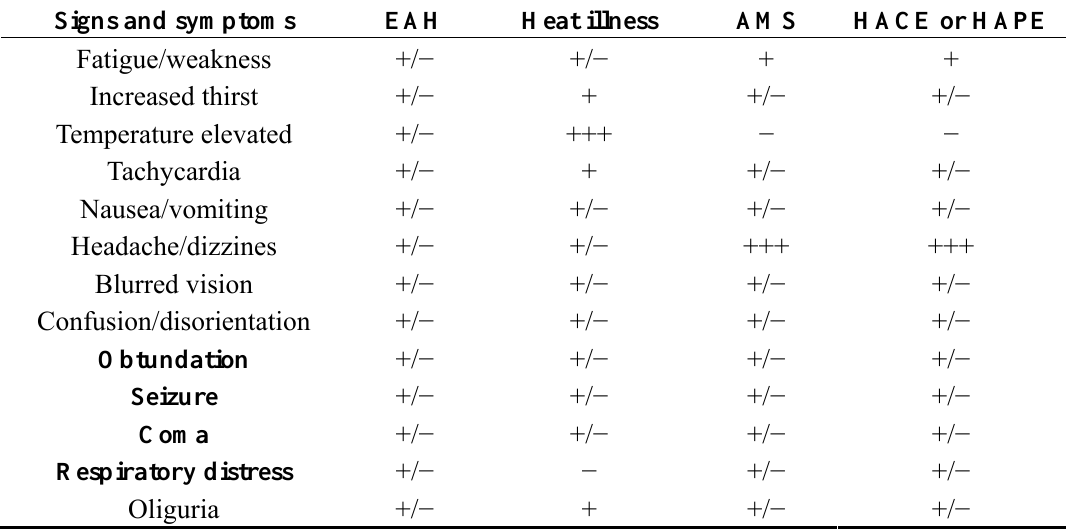
Table 2. Signs and symptoms of differential diagnosis (adapted from